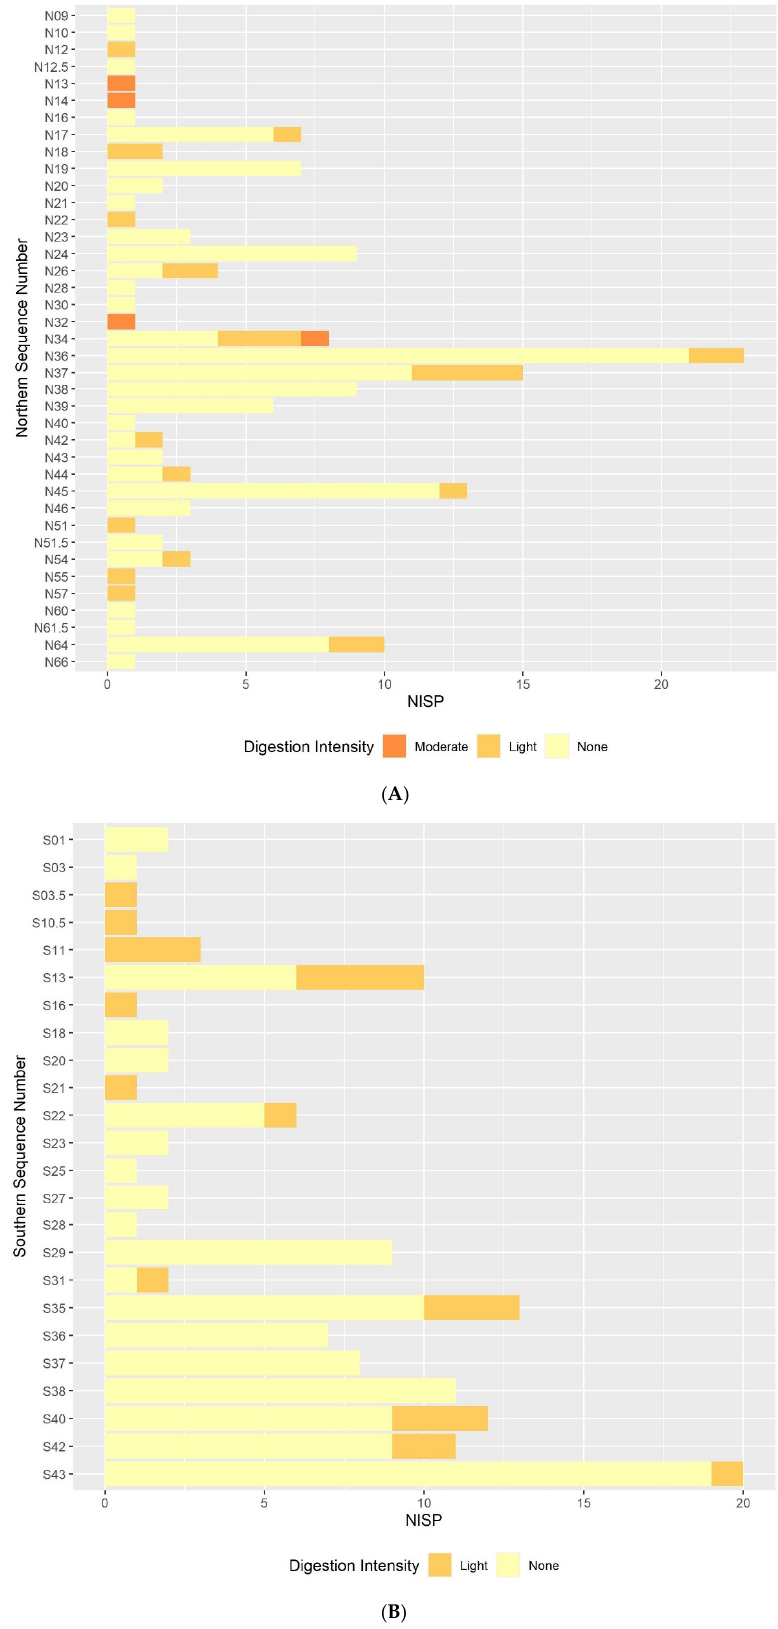
Figure 4. Observed humeri digestion intensity in the northern ( A ) and southern ( B ) sequence. NISP: number of identifiable specimens.